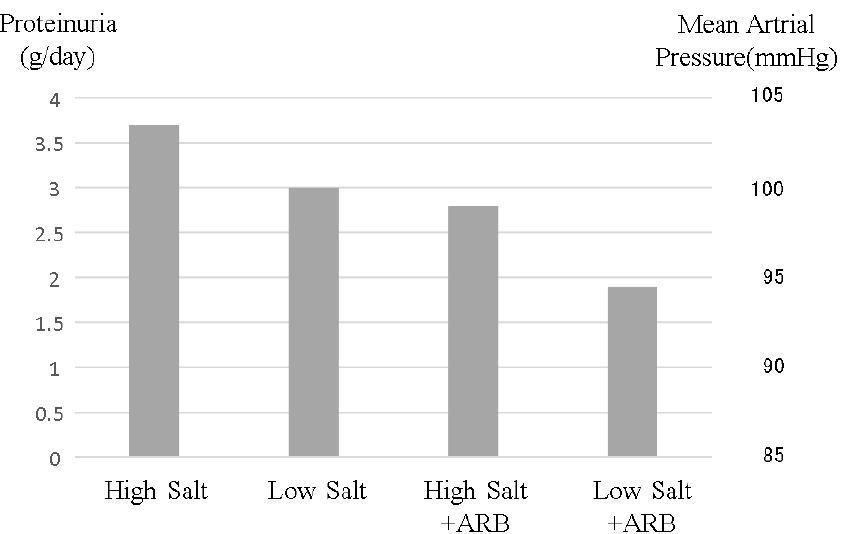
Figure 4. Changes in proteinuria and blood pressure induced by salt intake and angiotensin-receptor blocker administration. High salt intake increases both blood pressure and proteinuria. Although angiotensin-receptor blockers are well known to reduce blood pressure and proteinuria, resulting in reno-protective effects, high salt intake reduces these renoprotective effects. This image was made from data reported by Vogt et al. [28], but this phenomenon is common in CKD patients.